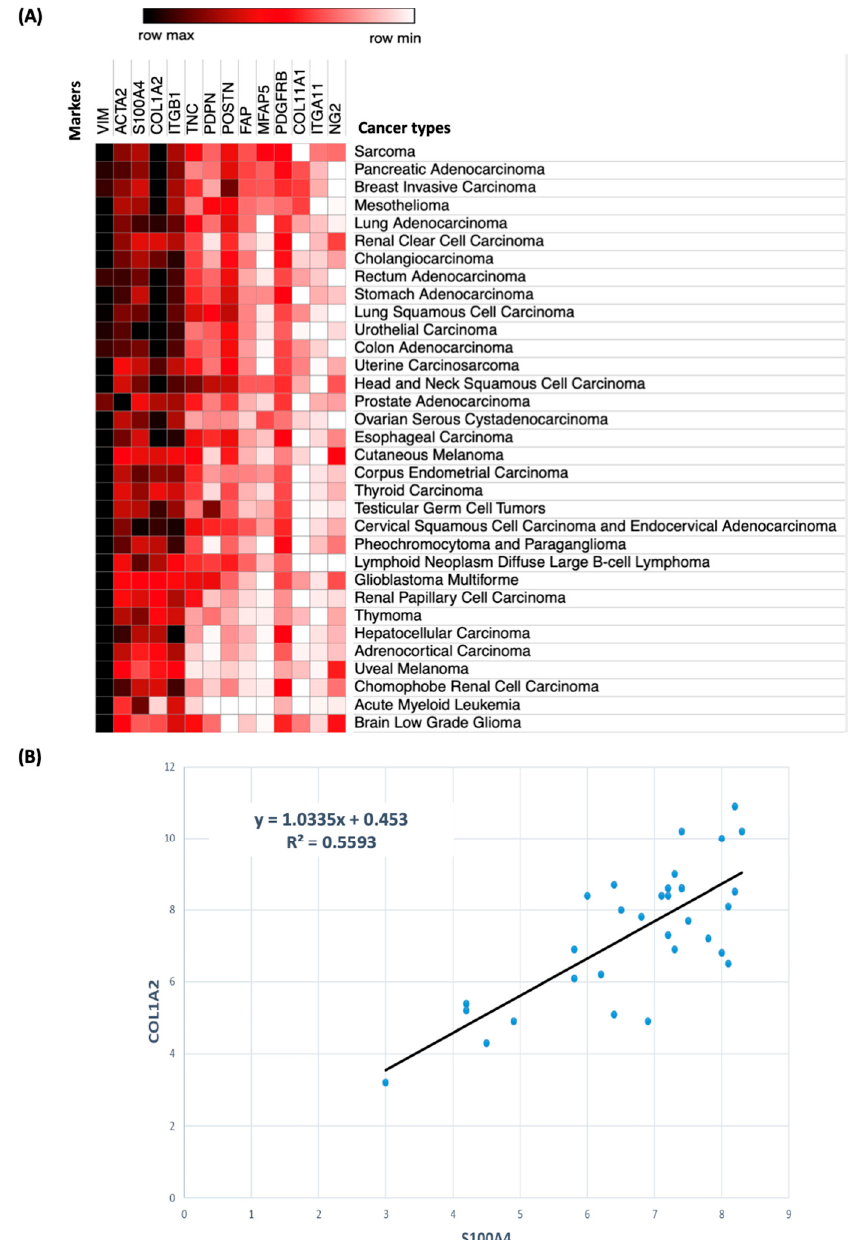
Figure 3. In silico gene expression analysis of 14 genes expressed by CAFs in human tumors. ( A ). Heat map representation of the expression of 14 genes (column) among 33 types of cancer (row). Data were generated by Gene Expression Profiling Interactive Analysis (GEPIA) of The Cancer Genome Atlas (TCGA) database; ( B ). Correlation analysis between the expression of S100A4 and COL1A2 in cancer.